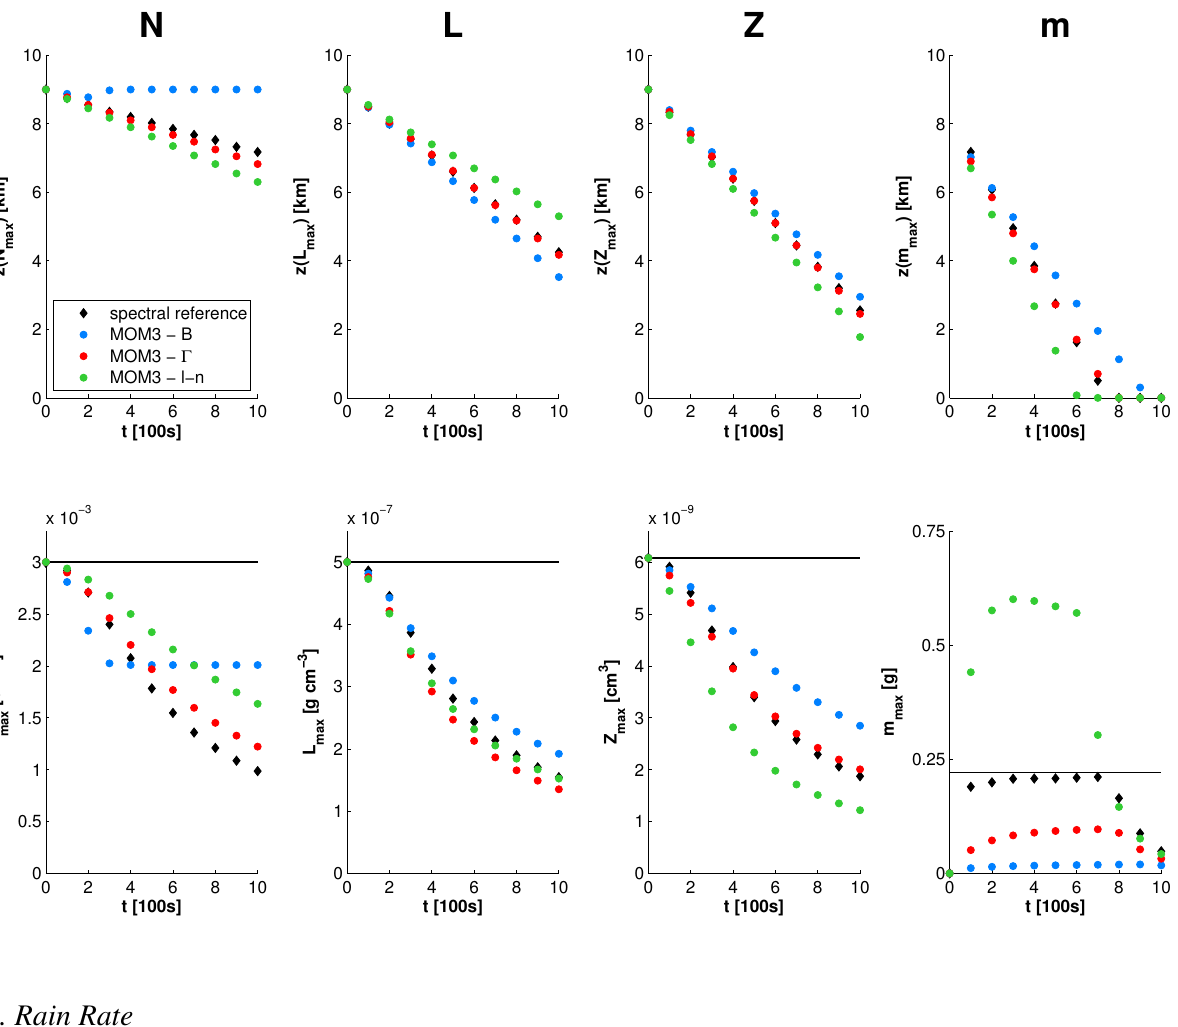
Figure 6. PAR case: maximum values (bottom) and corresponding heights (top) of N , L , Z and m for the reference (black) and the MOM3 models (color coding as in Figures 2 and 3). For the thin black line in the bottom row, see the